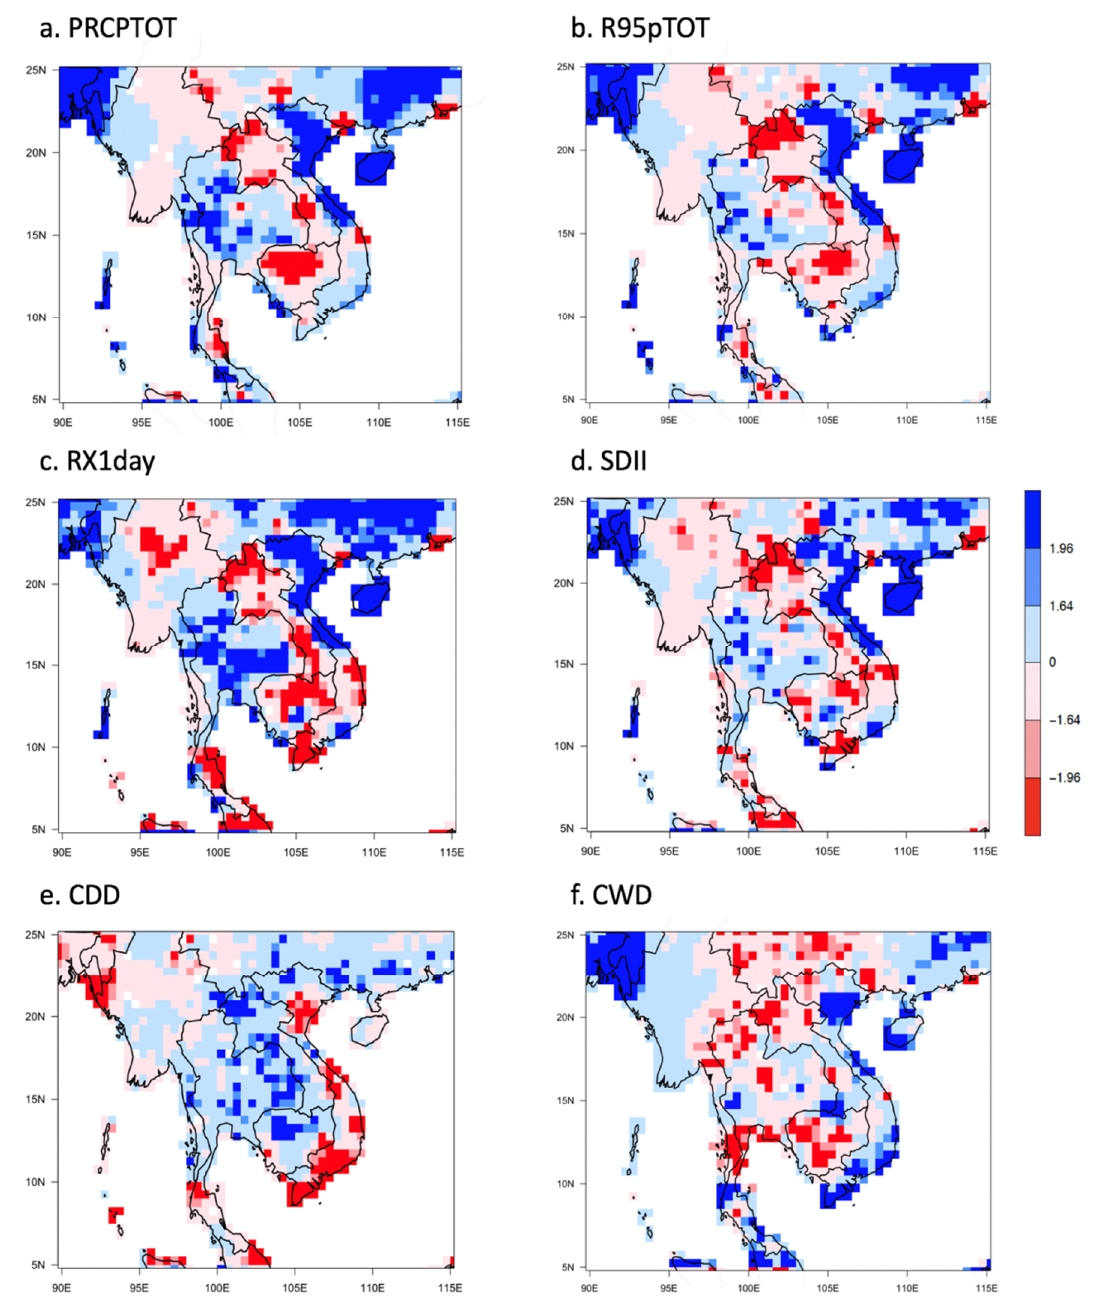
Figure 5. Long-term trend in seasonal precipitation for the wet season (May–October) over the ICP during 1979–2018. ( a – f ) show the analysis results of the six major climate change indices that reflect the magnitude and frequency of precipitation. In each panel, positive and negative trends are displayed in blue and red, respectively. The magnitude of Z is associated with the significance level, i.e., | Z | > 1.64 is for the 10% significance level and | Z | > 1.96 is for the 5% significance level.